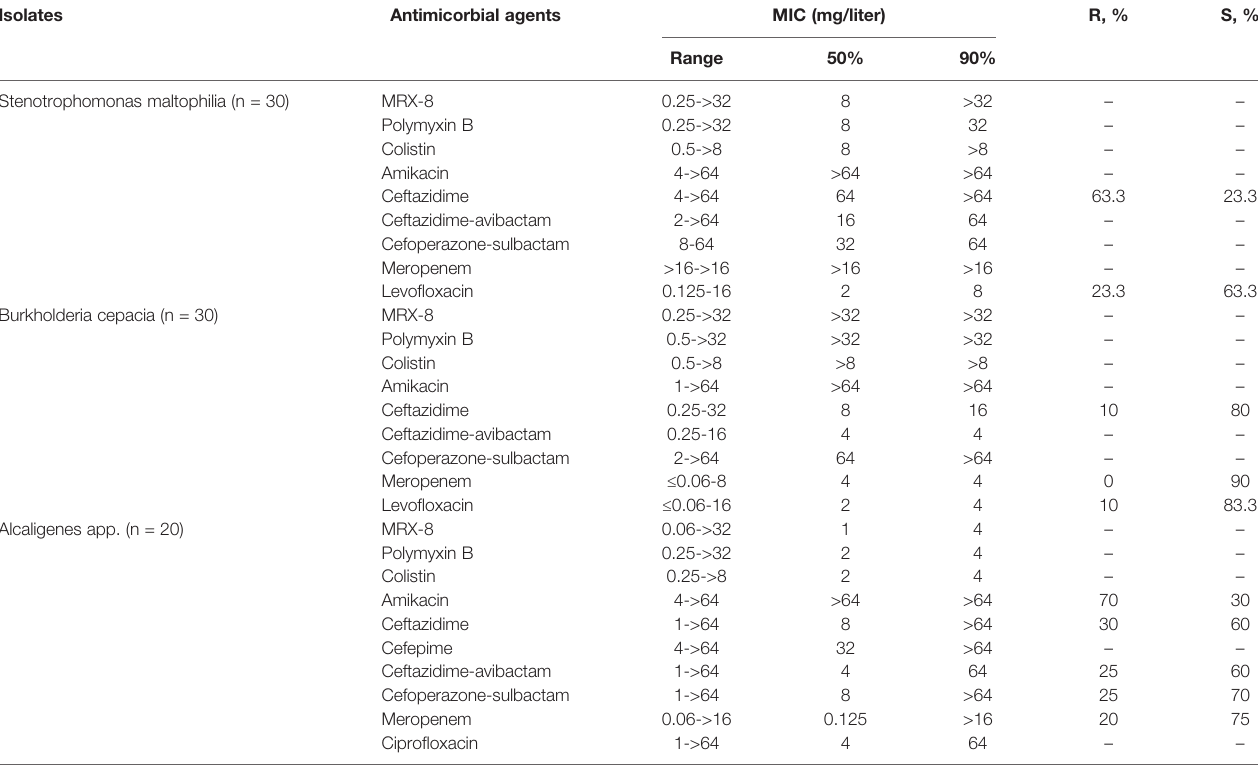
TABLE 6 | In vitro activity of MRX-8 and other comparator agents against 80 of other non-fermentative bacteria (mg/L). Isolates